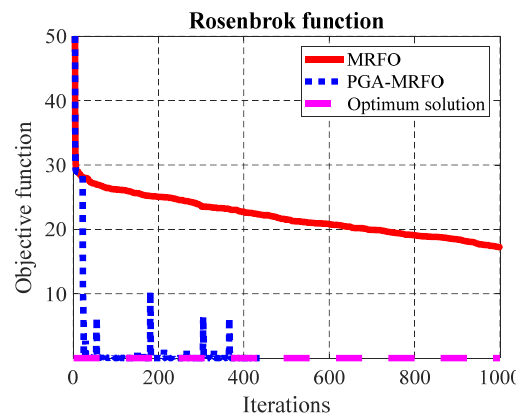
Figure 2. Converges curves for F 5 .